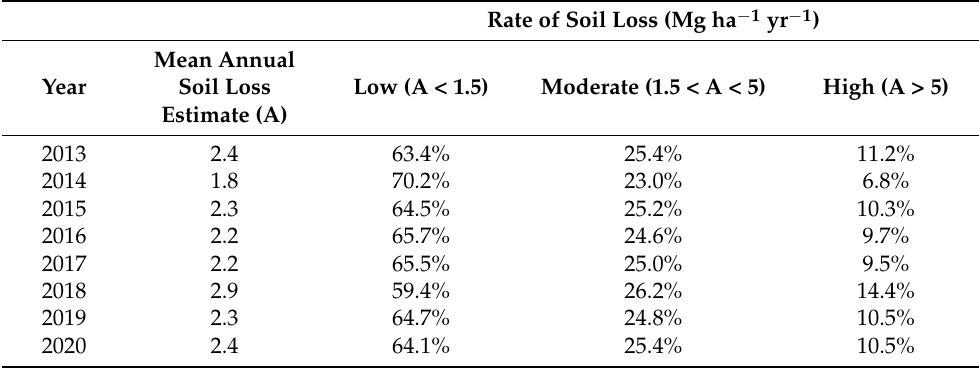
Table 8. Annual Soil Erosion Estimates from 2013–2020.